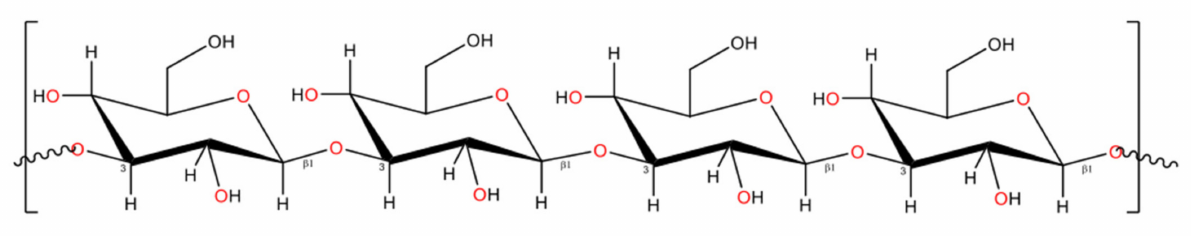
Figure 10. Structure of β -(1,3)-glucans,